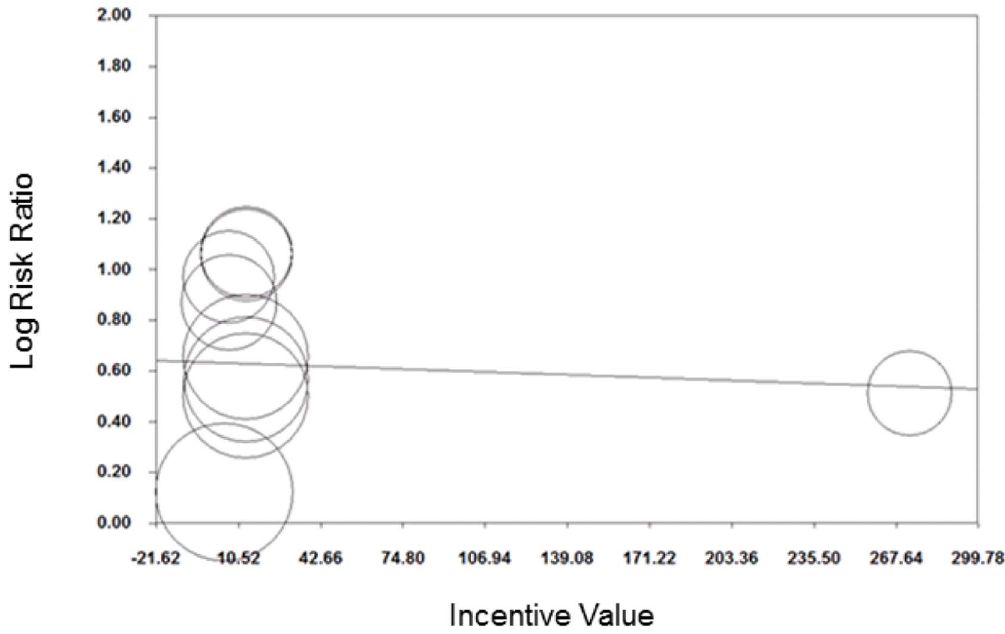
Figure 12. Meta-regression of incentive value on relative risk, attendance at vaccination & screening.